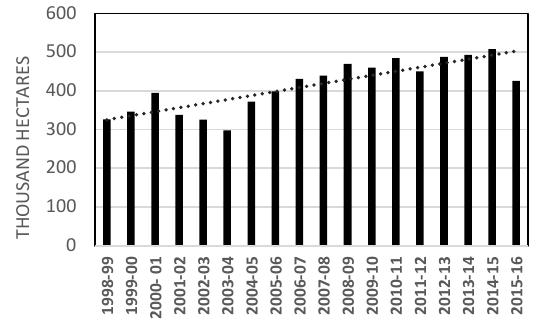
Figure 3. Growth in net irrigated area in Belgaum district of Karnataka